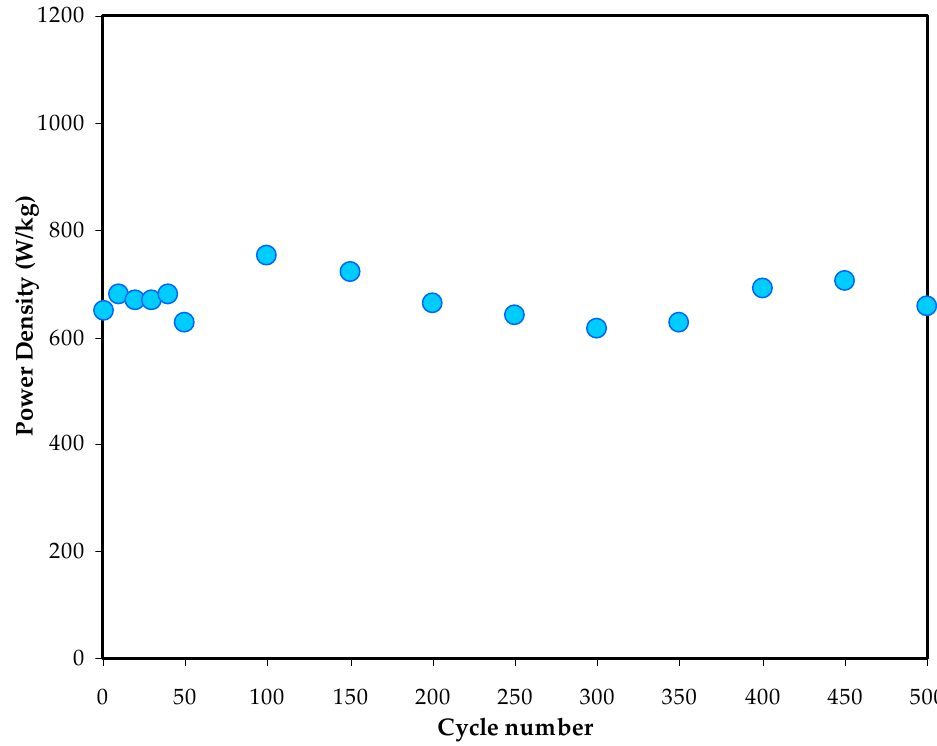
Figure 19. Energy density ( E ) trend of the fabricated EDLC over 500 cycles.